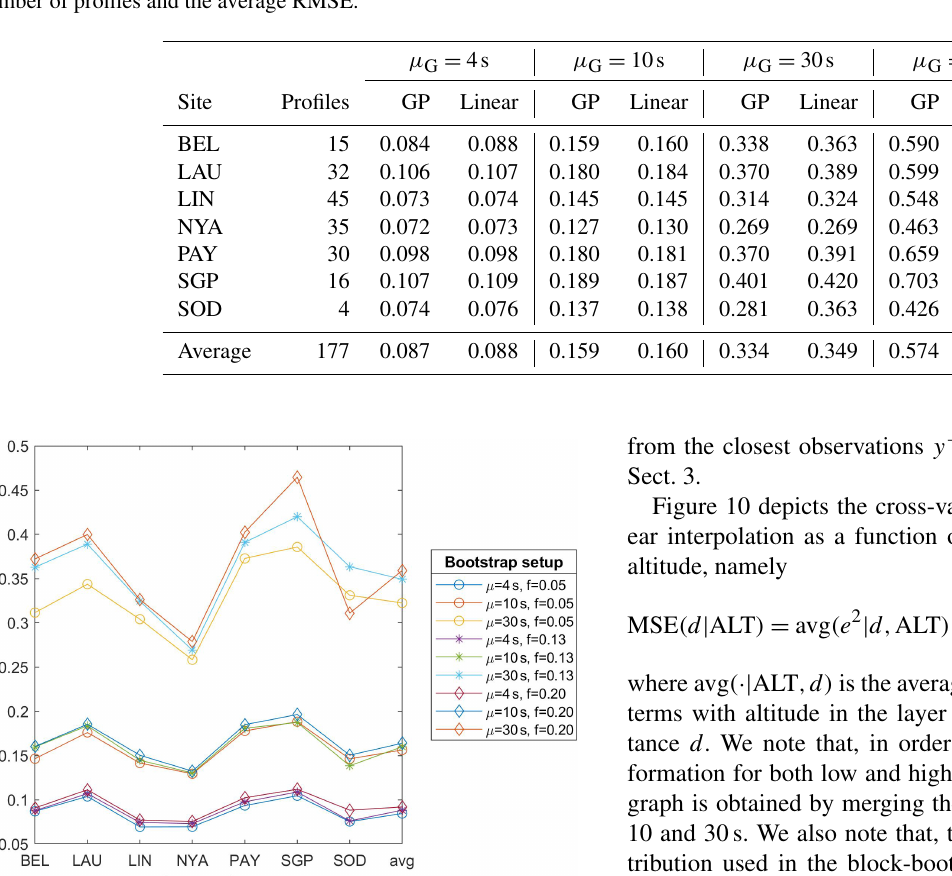
Table 2. Comparison of cross-validation RMSEs between GP and linear interpolation for increasing average gap length µ G = 4, 10, 30 and 60s. Cross-validation is based on B = 50 block-bootstrap replications, each with missing fraction f = 0 . 13. The last line reports the total number of profiles and the average RMSE.